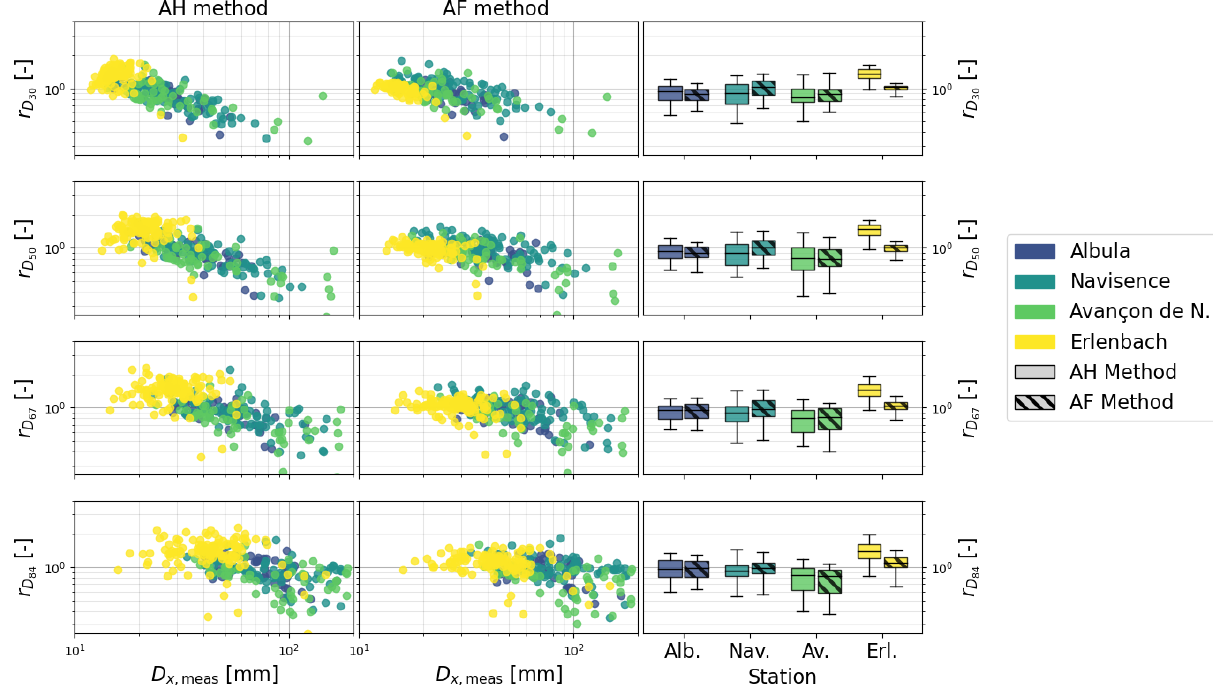
between the estimated and measured characteristic grain sizes D 30 , D 50 , D 67 , and D 84 as a function of the measured Figure 11. Ratio r D x grain diameter D x, meas for each collected sample i and each station using the AH method (column 1) and the AF method (column 2). D x is the grain diameter for which x percent of the sampled bedload is finer. The box plots in column 3 indicate the range of r D for each station. The boxes in solid colors show the results obtained with the AH method, and the hatched boxes show the results obtained with the AF